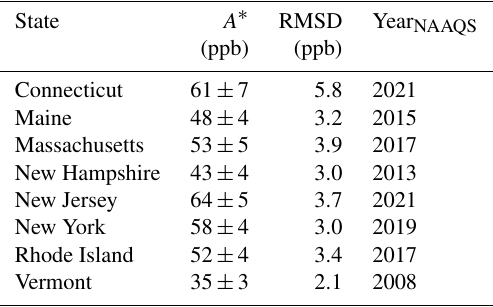
Table 3. Results of least-squares fits of Eq. (1) to the state maximum ODVs illustrated Fig. 10; y 0 and τ were held constant at 45.8ppb and 21.9 years, respectively. The absolute root-mean-square devia- tions between the observed ODVs and the derived fits are indicated. Year NAAQS indicates the projected year that the fit to the state max- imum ODV drops to the NAAQS of